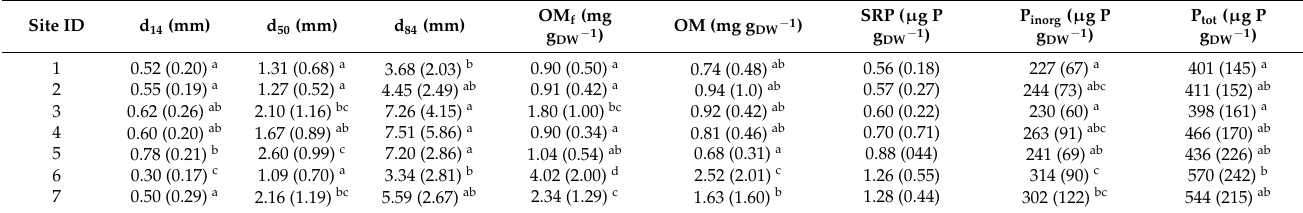
Figure 3. Principal component analysis with the sampled parameters. In ( a ), arrows indicate the projection of each multivariate axis on the first two principal component axis (PC1 and PC2). Points represent individual samples. Subplots ( b ) and ( c ) represent the centroids of the data points aggregated respectively by sampling site and event. The points in ( b ) and ( c ) represent the cloud centroid; the bars represent the standard deviations. Table 4. Characteristics of the sampling sites. Means (standard deviation) of the quantities that are not affected by hydrology are reported (n = 25). Letters in the superscript represent the result of the Tukey (cid:48) s post-hoc test. Refer to table S1 for the full ANOVA results. Note: SRP does not show the post-hoc test results because it was not aggregated per sampling site for further analyses. Note: d 14 , d 50 , d 84 = representative grain sizes, OM f = fine organic matter, OM = organic matter, SRP = Soluble Reactive Phosphorous, P inorg = inorganic phosphorous, P tot = Total Phosphorous. Refer to Section 2.3 for the explanation of the